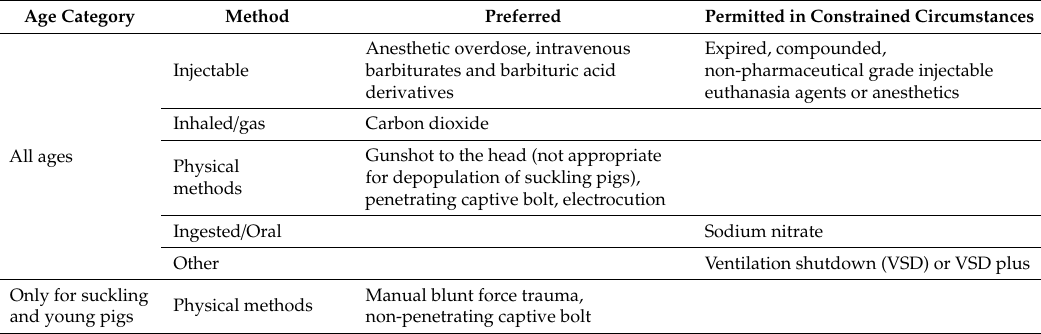
Table 1. List of preferred swine depopulation methods as well as those permitted in constrained circumstances. Age